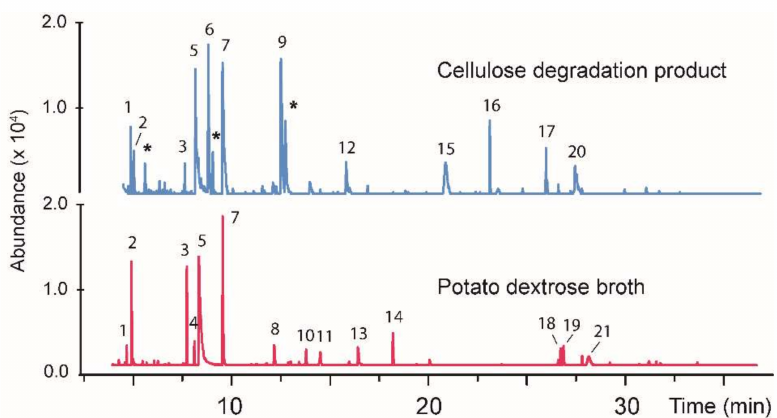
Figure 4. A gas chromatogram showing the volatile organic products produced by the fungus BS15 growth on a conventional media ( bottom ) and on carbohydrates produced from the degraded cellulose ( top ). The asterisks (*) denote volatile contaminants occurring in the degraded cellulose media as determined by analyzing a control sample with no BS15 added. The tentative identification and nominal masses of the individual peaks numbered in the chromatogram are given in Table 2.